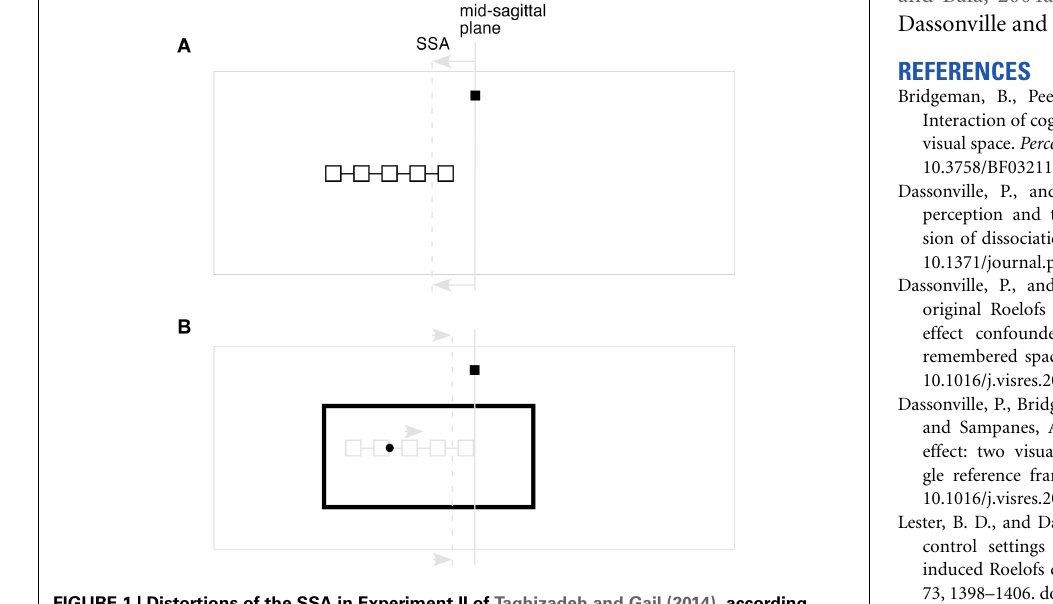
FIGURE 1 | Distortions of the SSA in Experiment II of Taghizadeh and Gail (2014), according to the predictions of the Two-Wrongs model of visual processing. (A) The initial step of stimulus presentation, showing the central fixation point (small square), and a reference array shifted to the left of the participant’s mid-sagittal plane (solid gray line). Like the offset rectangle in the typical IRE, the offset reference array would serve to attract the participant’s SSA (dashed gray line). (B) The subsequent appearance of the cue and Roelofs-inducing rectangle, after the reference array has been extinguished. In spite of the inducing rectangle’s bias toward the left hemifield, its center of gravity is not as lateralized as that of the earlier reference array. This would cause the SSA to move rightward, pulling the memory of the reference array with it, and causing the cue to be mislocalized toward the left end of the remembered reference array. Although the image shows the SSA as moving directly between the distorted positions caused by the sequential presentation of the reference array and the later Roelofs-inducing rectangle, this change in the SSA need not be direct (for example, the SSA may drift back toward the objective midline during the delay period between reference array and inducing rectangle presentations, only to be pulled leftward again when the inducing rectangle is presented; see Dassonville and Bala, 2004a). Importantly, the direction and magnitude of the IRE would depend only on the relative locations of the distorted SSA during reference array and target presentations, regardless of its possible meanderings between those